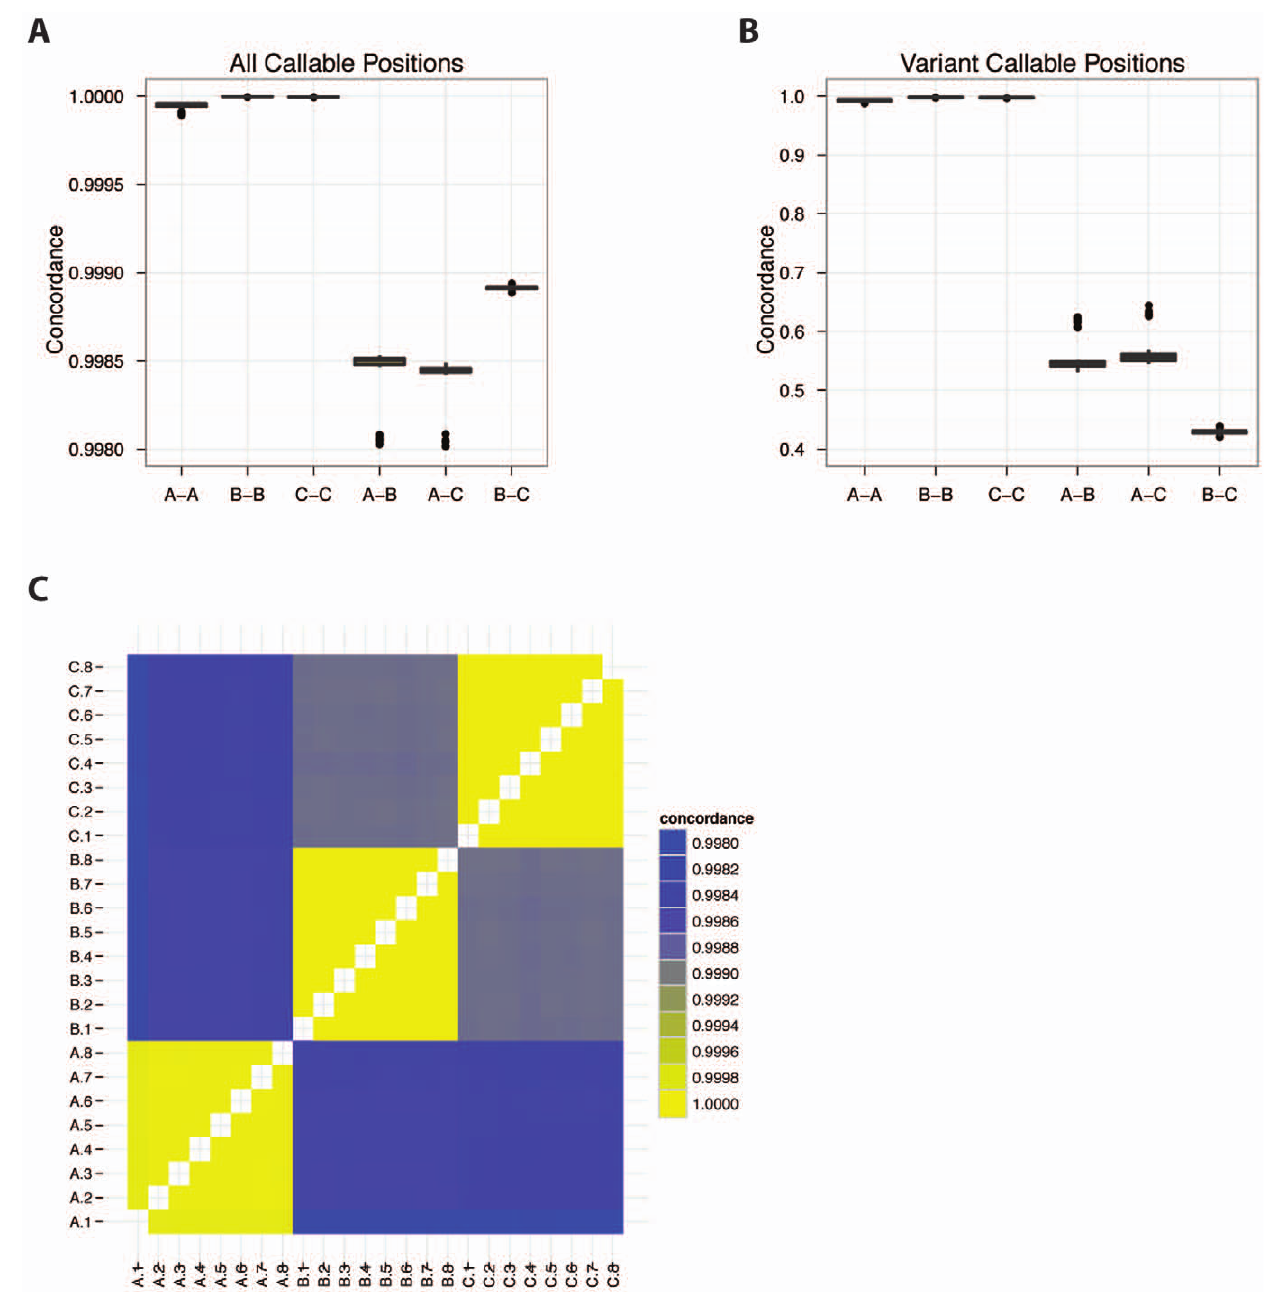
Figure 2. Concordance between lanes. Distributions of genotype concordance rates from same- and different-sample comparisons are non- overlapping. The box plot in (A) shows the distributions of concordance rates when using all callable positions for all combinations of pairs of the three samples being analyzed. The x-axis denotes each pair being compared (A, B, and C, refer to the sample IDs in Table 1), and the y-axis represents the distribution of concordance rates for all pair-wise combinations of lanes representing the specific pair of samples on the x-axis. It is likely that the detected differences from same-sample comparisons (B–B, C–C, and A–A) arise solely from sequencing and genotyping error. The box plot in (B) is similar to (A), except that here only variant (nonreference) positions are considered. The symmetrical heat map in (C) summarizes the data from panel (A); the blue boxes represent low concordance rates and correspond to different-sample comparisons, while the yellow boxes along the diagonal represent high concordance rates and correspond to same-sample comparisons. Note that comparisons between samples B and C (gray boxes) are slightly more similar to each other than the other different-sample comparisons, but still sufficiently distinct from same-sample comparisons. This is expected given the known partial consanguinity between these individuals.